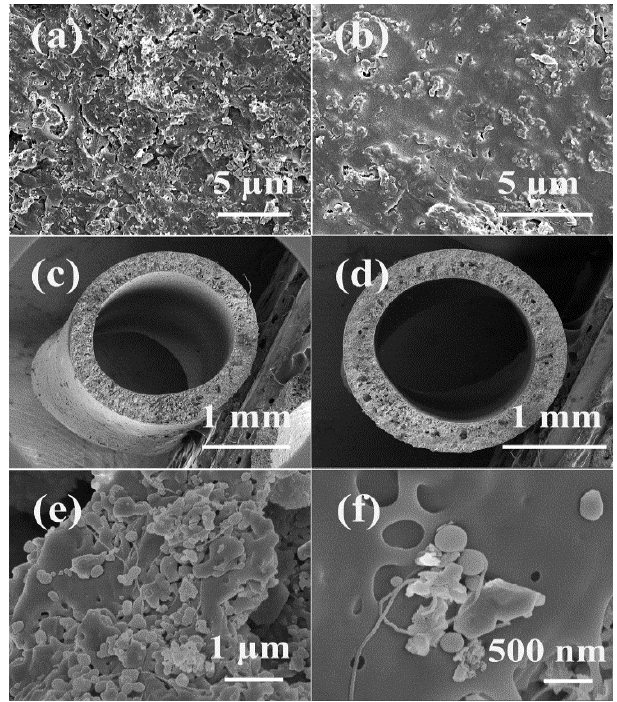
Figure 1. SEM images of membrane surface of samples ( a ) without carbon nanotubes (CNTs) and ( b ) with 0.5 wt % CNTs loading, cross-section of samples with ( c ) 0 wt % and ( d ) 0.5 wt % and ( e , f ) CNTs dispersed among alumina and polymer (0.5 wt % CNTs/alumina/PES